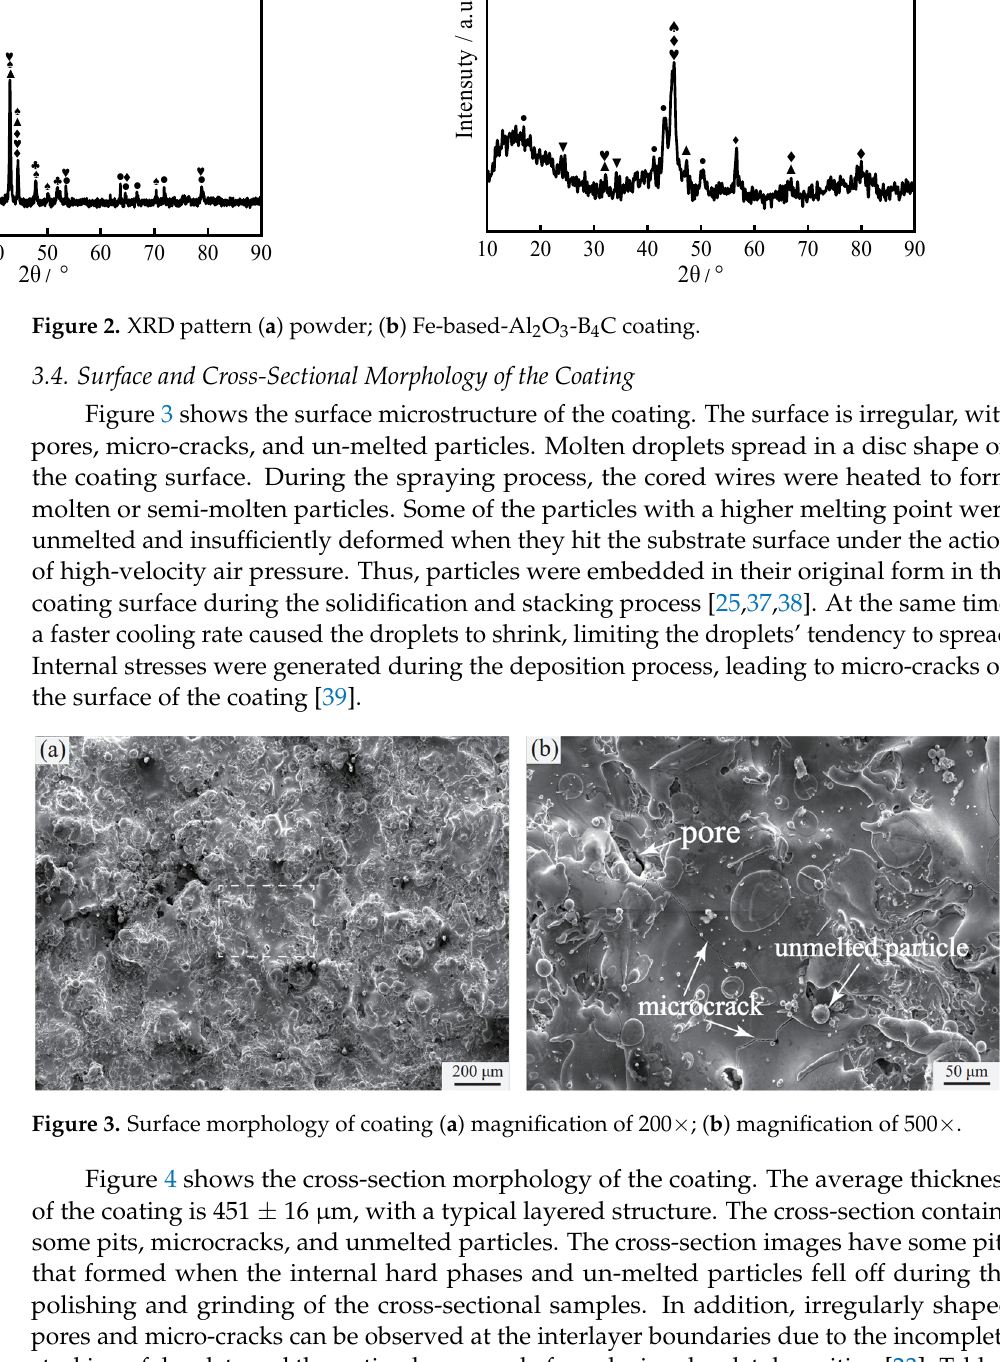
area III. The main composition of the light grey area I is 76.85% Fe, 14.77% Cr and a small amount of Mn, Ni, and Al elements. The light grey area I is mainly composed of Fe-Cr metal compounds, which is consistent with the XRD